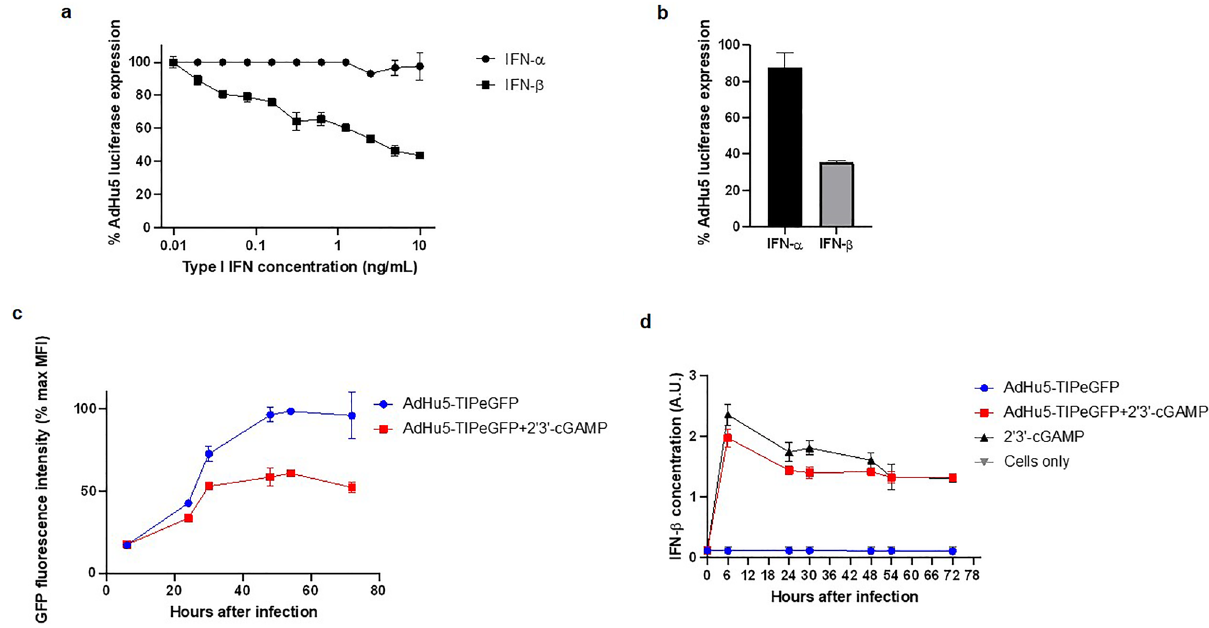
Figure 3. IFN-β induced by exogenous 2 ′ 3’-cGAMP correlates with AdHu5 transgene expression. ( a ) Percentage of AdHu5 luciferase expression was dependent on the concentration of human IFN-α/β (MOI 12). ( b ) AdHu5 luciferase expression at a concentration of 5 ng/mL of murine IFN-α/β in the murine cell line Hepa1-6 (MOI 12). Luciferase activity was measured 48 h after viral infection. ( c ) Effect of 2 ′ 3 ′ -cGAMP (83.3 mM) on the kinetics of eGFP expression from AdHu5-infected Hepa1-6 cells (MOI 1000). ( d ) Kinetics of IFN-β production from the same experiment as ( c ). For panels a & b , IFN-α is used as a negative control 38 . For all experiments, mean values + SD are shown for each time point and IFN concentration; these values were obtained from 3 technical Optimization of the delivery of 2 ′ 3 ′ ‑cGAMP to enhance transgene‑specific CD8 + T cell responses. Having identified early STING signaling negatively impacting transgene immunogenicity, yet wanting to optimize the use of 2 ′ 3 ′ -cGAMP to enhance CD8 + T cell responses, we generated a bicistronic vector to ensure simultaneous transgene and STING signaling. We constructed an AdHu5 co-expressing the transgene antigens (Pb9, P15, eGFP 200-208, AL11 and eGFP) and the natural 2 ′ 3 ′ -cGAMP synthase, also known as cGAS 24 (Supplementary Fig. S1). As a control, the same antigen insert was co-expressed with inactive version of cGAS containing relevant inactivating point mutations 24 . The expression and activity of the encoded cGAS was confirmed in vitro (Supplementary Fig. S7). In vivo immuno- genicity showed that the delivery of 2 ′ 3 ′ -cGAMP after viral infection (by means of co-expressing it as a transgene) enhanced the CD8 + T cell immunogenicity against Pb9 and eGFP 200-208 (Mann–Whitney test: ** p = 0.0070 and * p = 0.0467, respectively), but not the CD4 + T cell immunogenicity against P15 ( p > 0.05) (Fig. 4a–c). Enhance- ment of the CD8 + T cell response was also observed when AdHu5 vectors were administered by intradermal injection (* p = 0.0286 for Pb9 and p = 0.400 for eGFP 200-208 ) and same trend observed at different viral vector doses ( p = 0.3719 and * p = 0.0286 at doses 10 6 and 10 8 , respectively) (Supplementary Figure S8 & S9). However, the transgene immunogenicity induced by cGAS-expressing AdHu5 was lower than control AdHu5 expressing only the transgene antigens (Fig. 4a–c), suggesting an impact of the co-expression system. Reduced but equivalent level of eGFP was observed with both cGAS-expressing vectors compared to the AdHu5 (Supplementary Figure S7 a), but only cGAS, and not the mutant, induced IFNβ production in vitro. Since the only difference between vaccines was their ability to deliver 2 ′ 3 ′ -cGAMP, we consider the above experiments still valid for assessing the effect of 2 ′ 3 ′ -cGAMP on the transgene-specific CD8 + T cell immunogenicity co-expressed from the same vector